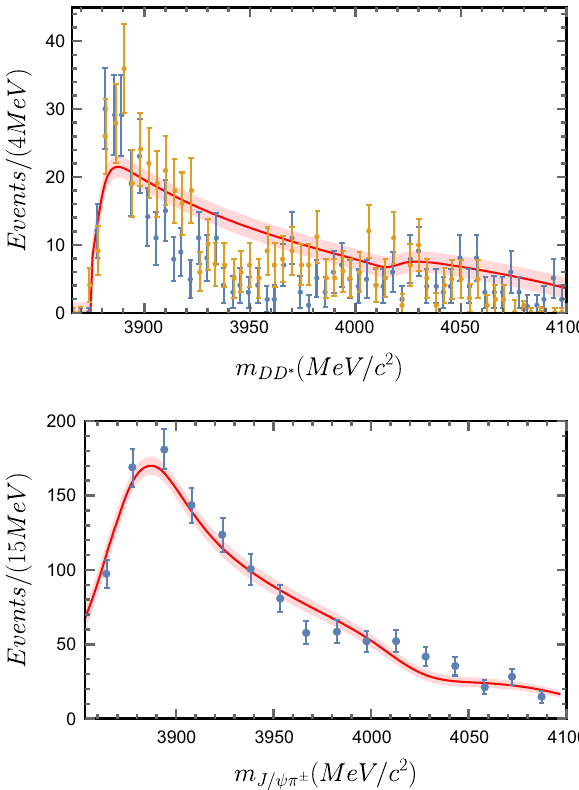
Fig. 2 Line shapes for D ¯ D ∗ (upper pannel) and π J /ψ (lower pan- √ s = 4 . 26 GeV. Experimental data are from Refs. [14,15], nel) at respectively. The theoretical line shapes have been convoluted with the experimental resolution. The line-shape’s 68% uncertainty is shown as a shadowed area